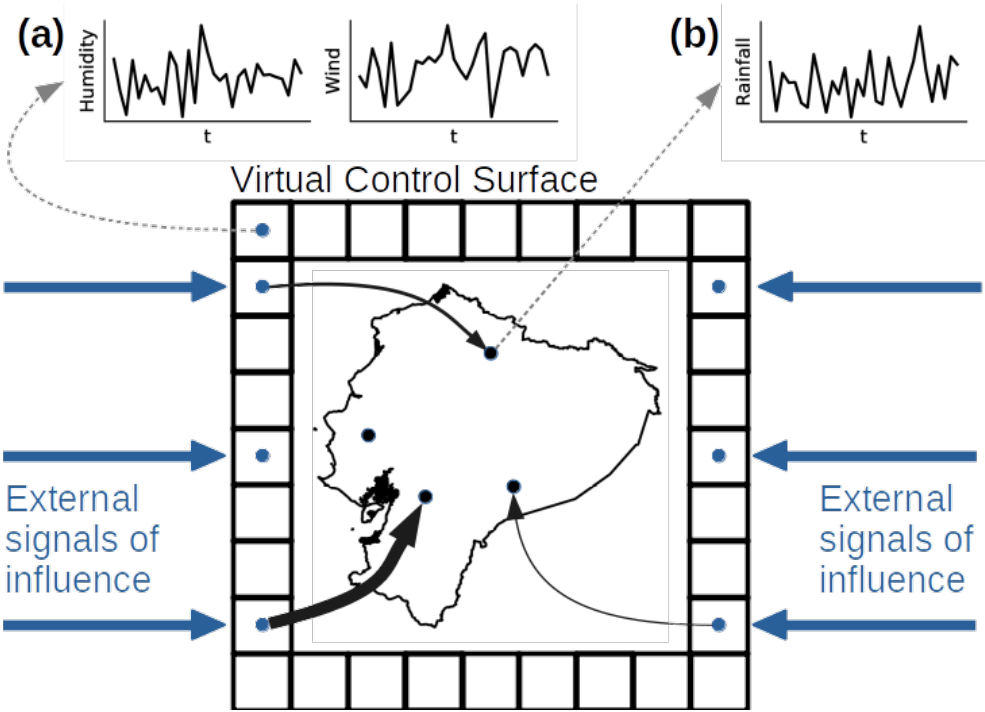
Figure 1. Outline of the proposed virtual control volume approach to study causal flows. The larger, straight arrows indicate the possible external influence towards the geographic region of interest (GRI). The control surface around the GRI is represented by the collection of squares, which contain time series of climatic variables that serve to infer external influence, e.g., humidity and wind ( a ). The causal flow is derived by employing a causality test between the climatic variable in the control surface ( a ) and a climatic variable in the GRI, e.g., rainfall ( b ). Arrows between the control surface and GRI indicate the existence of causal influence, and the thickness of the arrow indicates the intensity of the influence.